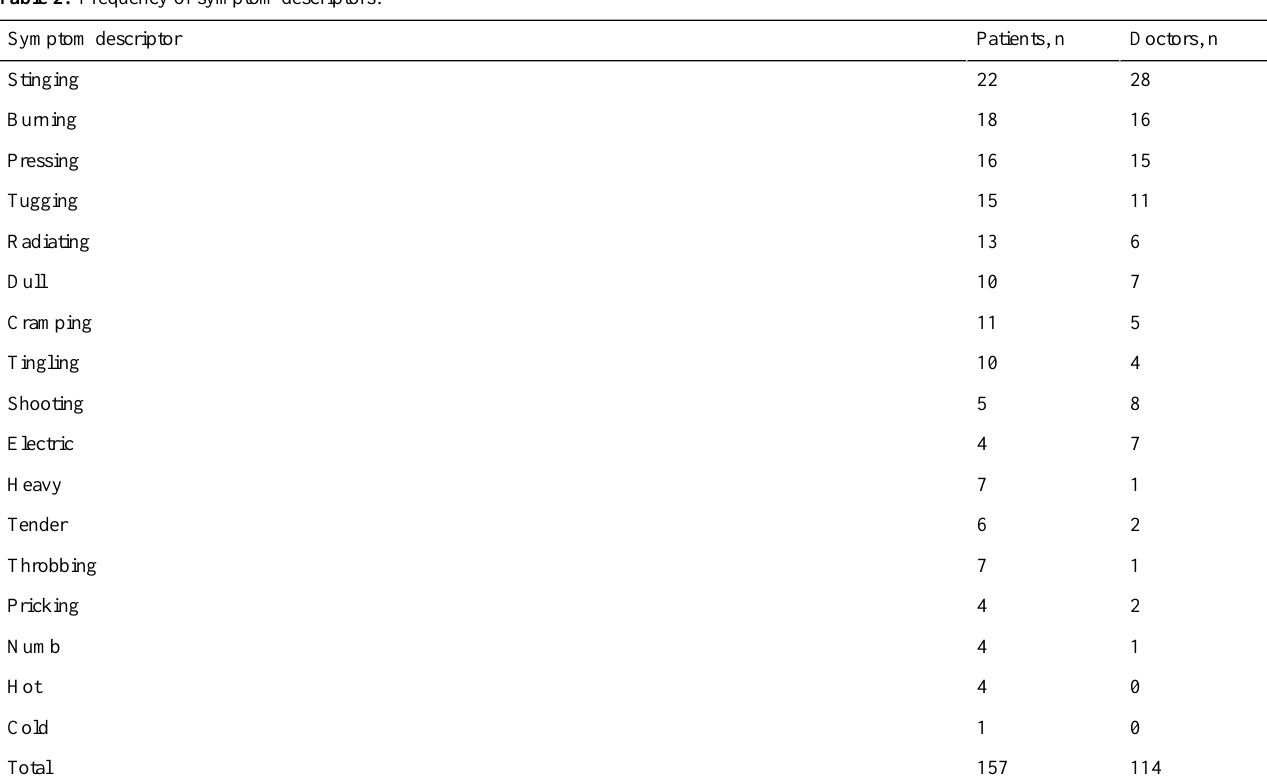
Table 2. Frequency of symptom